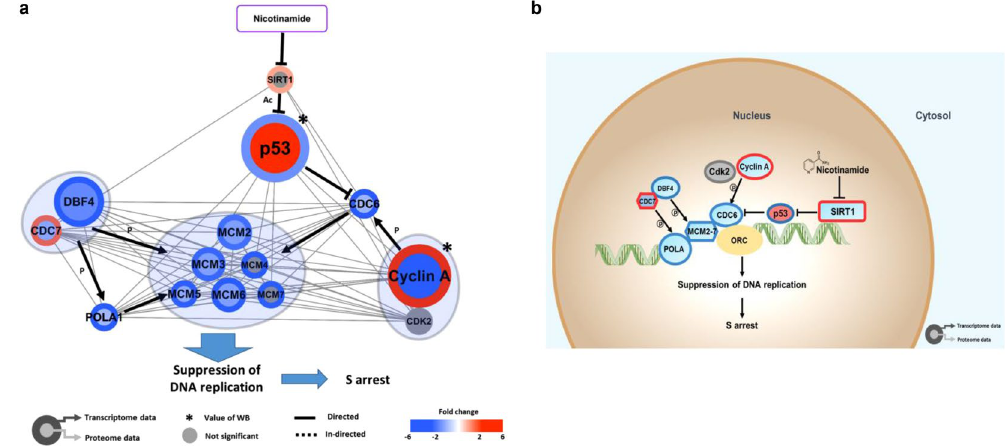
Figure 5. Regulatory network model of DNA replication coupled with nicotinamide. ( a ) The colors of the border and inside circle indicate the expression levels of transcriptome and proteome data, respectively. Gray edge indicates the protein-protein interaction based on the STRING database, whereas the arrows and inhibition symbols represent the activation and repression information. Nodes with asterisks indicate that the protein was assessed by only western blotting without the use of proteome data. There is no significant difference regarding the expression level if the color of the node is gray. Blue circle clustering highlights the complex enzymes of proteins. ( b ) Proposed model of nicotinamide-induced DNA replication interaction network. Networks are represented to reflect proteome, transcriptome and western blotting. Red indicates increased expression, blue indicates decreased expression and gray indicates no significant difference. Abbreviations: ac - acetylation, p - phosphorylation, WB - western